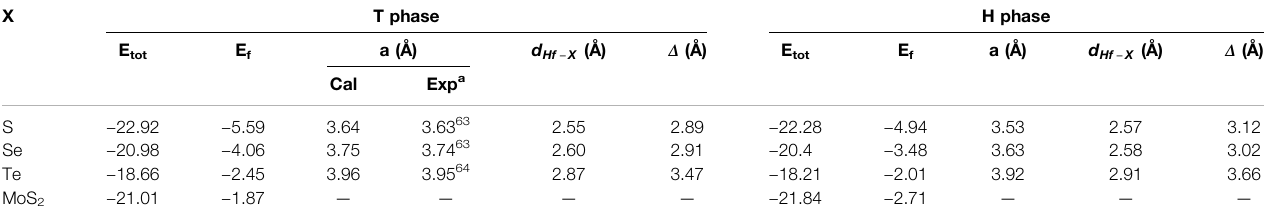
TABLE 1 | Total energy (E tot , eV), formation energy (E f , eV), the lattice constant (a, Å), chemical bonding between hafnium and chalcogen atoms ( d Hf − X , Å), buckling ( Δ , Å) of monolayer